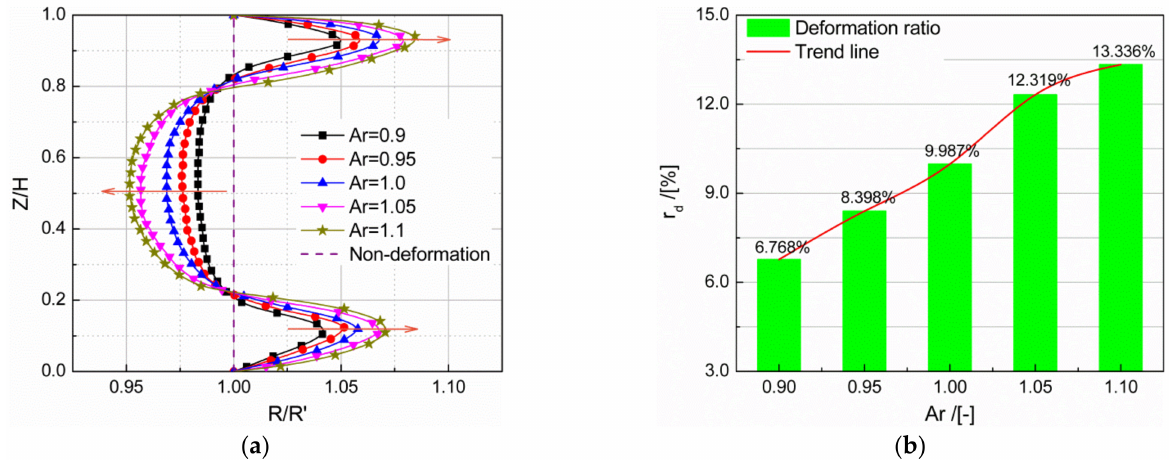
Figure 14. ( a ) Surface deformation with different aspect ratios; ( b ) Variation of deformation rate r d with Ar ( Ca C = − 0.01, R = 2.5 mm, H/R = 0.9, 0.95, 1.0, 1.05 and 1.1, Vr =